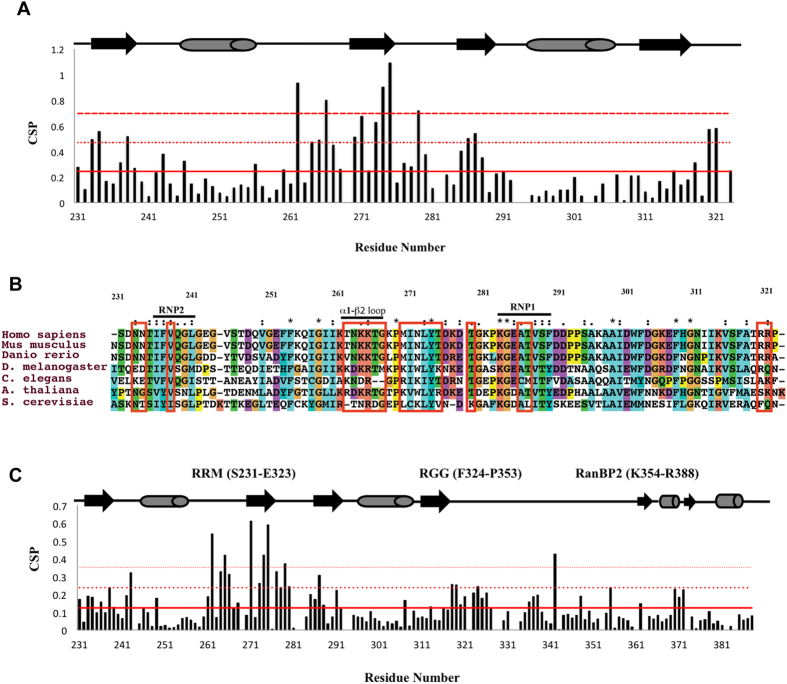
Chemical shift perturbation profile (CSP) of (A) TAF15-RRM and (C) TAF15-RRM-RanBP2 upon binding to 1.2 molar equivalents of SON stem-loop RNA. The solid, dotted and dashed horizontal red lines indicate averaged CSP, one and two standard deviations (σ) from the averaged CSP respectively. The secondary structural elements are shown on the top (thick arrows indicate β-strands, cylinders indicate helices and thick line segments indicate loops and the disordered regions). (B) Sequence alignment of TAF15-RRM with homologs from different distantly related species. Regions enclosed in red boxes correspond to the residues of TAF15-RRM undergoing significant CSPs upon binding with SON stem-loop RNA.